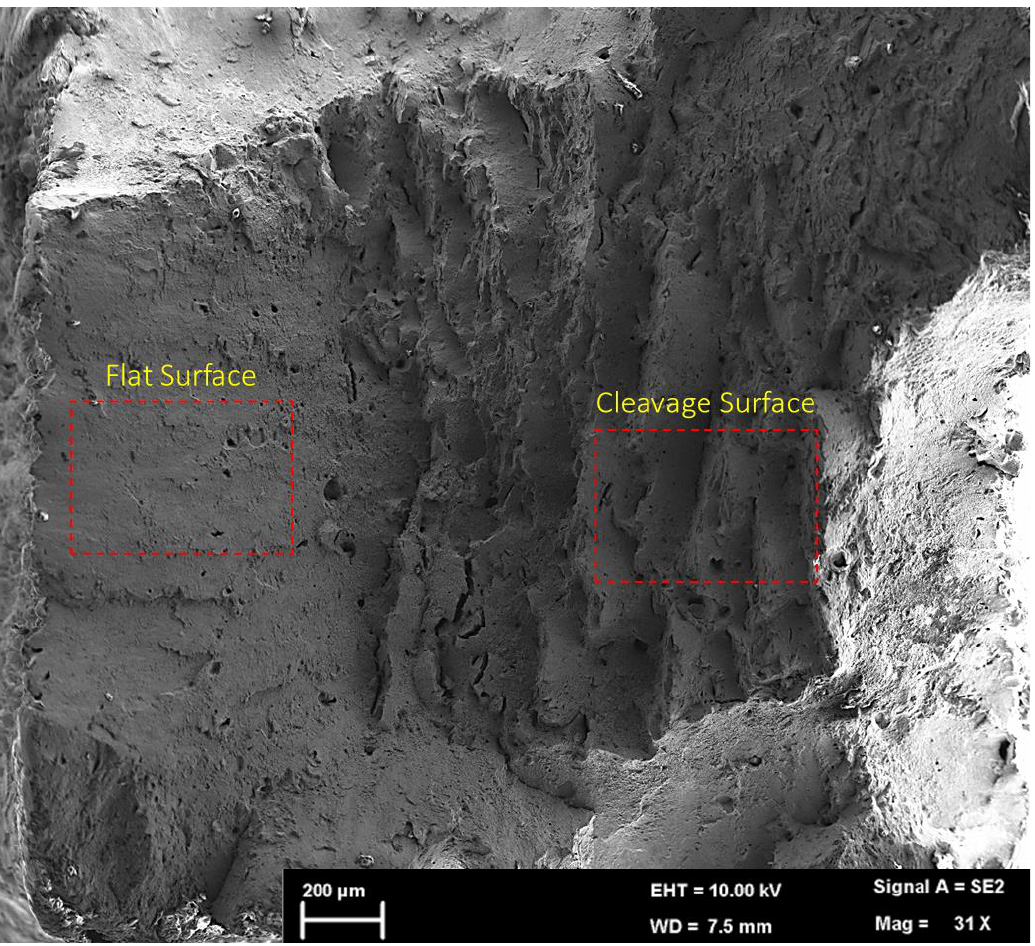
Figure 20. Fracture surface overall under SEM observation including flat and cleavage surface.